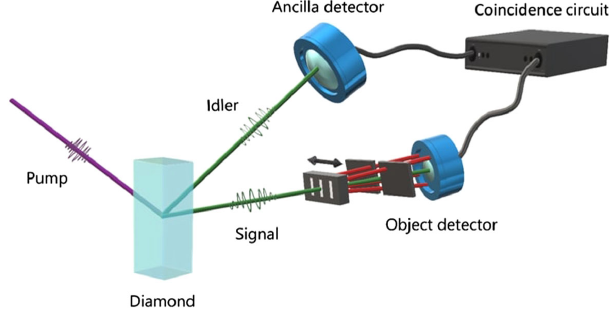
FIG. 1. Scheme of the experimental setup. The purple beam is the pump, the green beams are the signal and idler, respectively, and the red beams represent the noise radiation. The object is made of three slits. The detectors are silicon drift